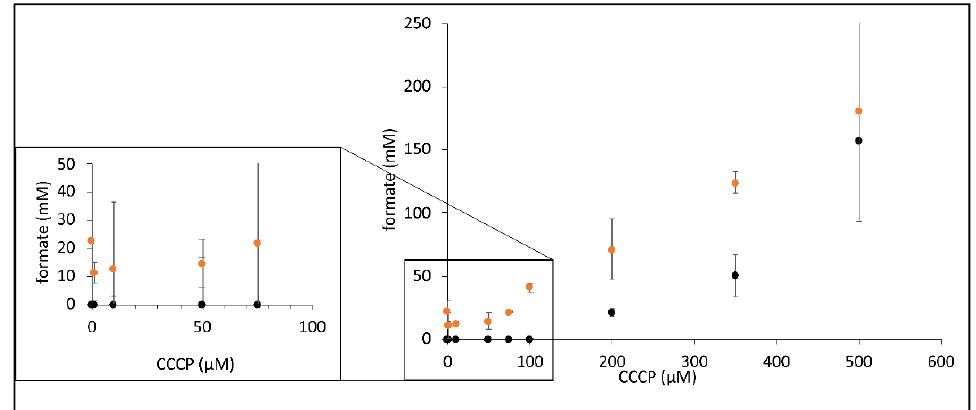
Figure 4. CCCP-dependent increase in formate synthesis by FHL. Strains MC4100 (parental, black dots) and CP734 (Δ hyaB Δ hybC , orange dots) were triggered for formate production in the presence of different concentration of CCCP as indicated (described in the Materials and Methods section). Each dot represents the average of three biological replicates with standard deviation.